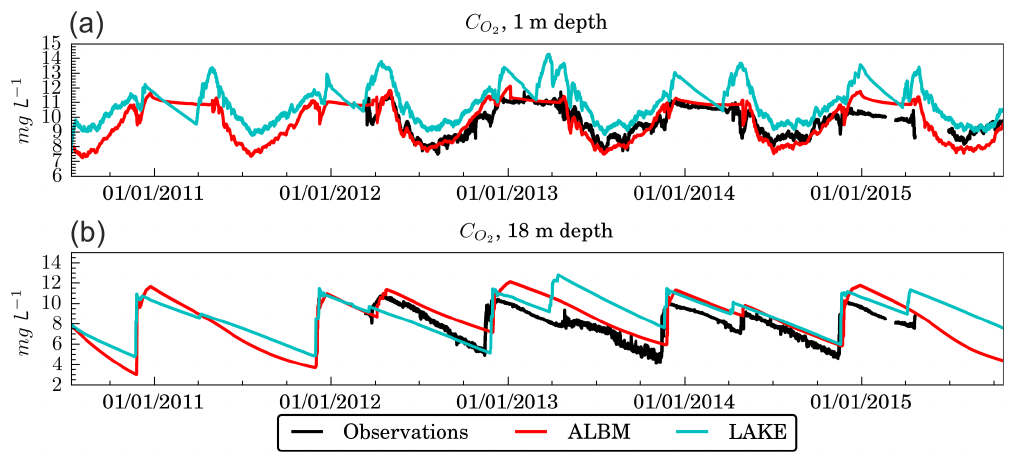
Figure 8. Time series of O 2 concentration at depths 1 and 18m, observed and